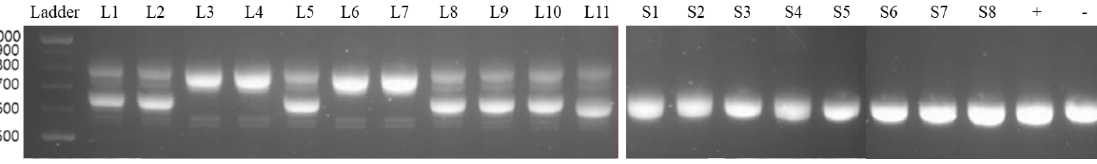
Figure 2. Gel image of the genotyping PCR of RSPO2 3' UTR to differentiate the long- and short-hair allele. Animal ID is shown on top with their phenotypes (L and S for long- and short-hair phenotypes, respectively). The target size of the PCR product for the long- and short- hair alleles was 817 bp and 676 bp, respectively. “+” and “ - ” indicates positive and negative controls,